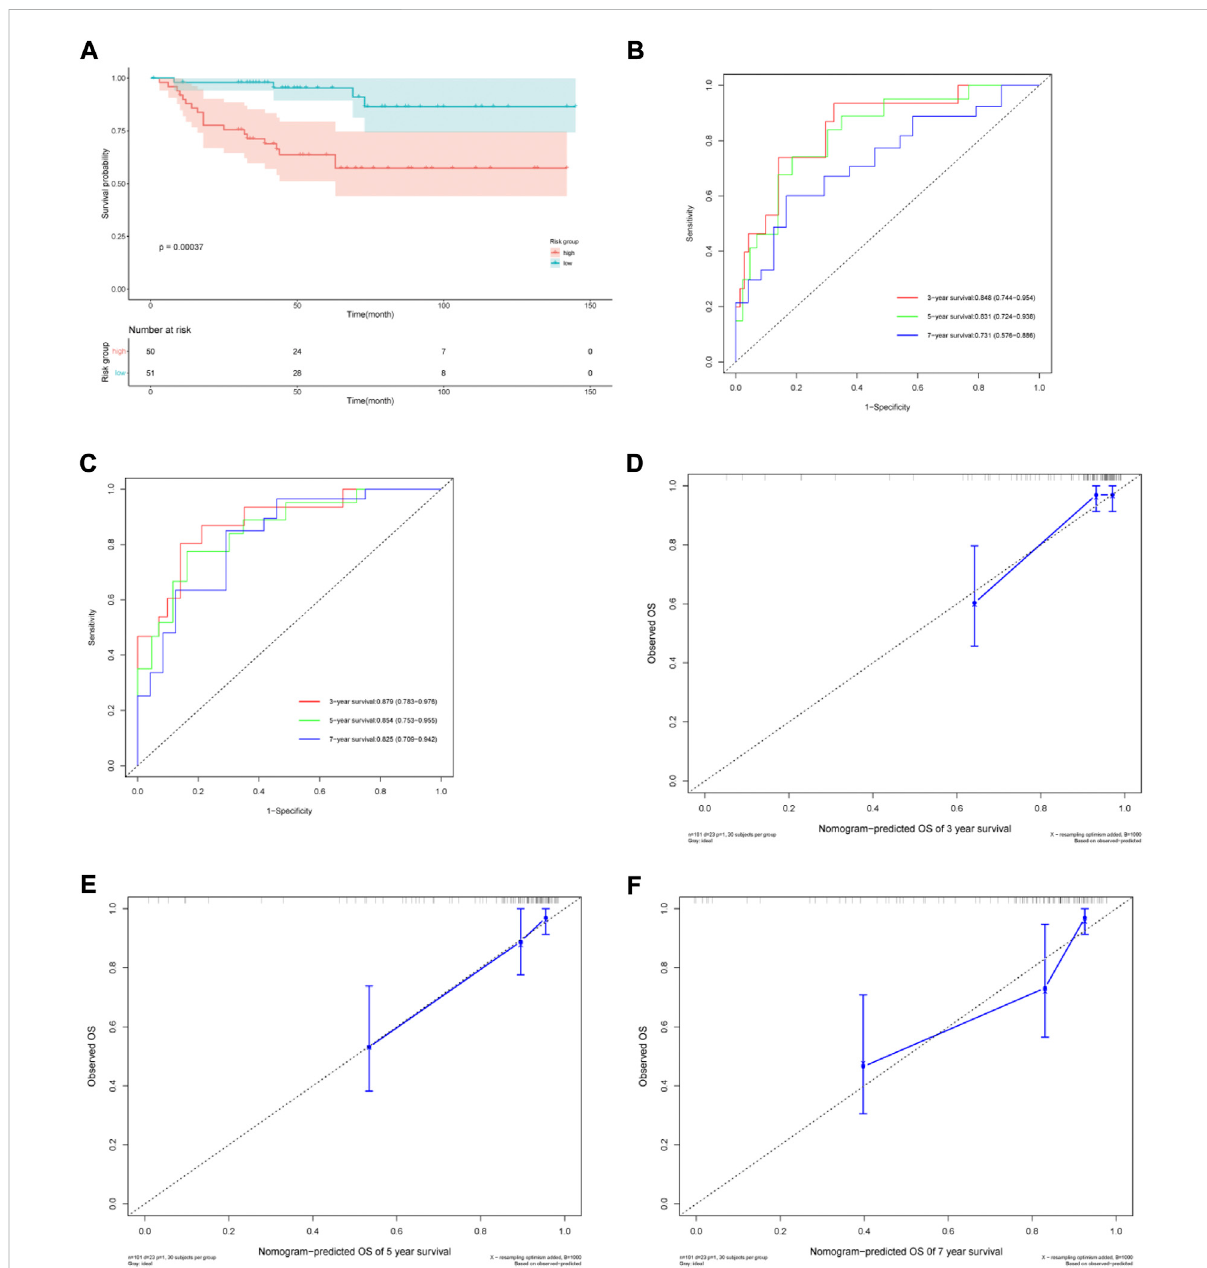
FIGURE 6 Validation of the prognostic risk model and nomogram. (A) Kaplan – Meier (KM) estimate of the overall survival (OS) in the two risk groups in the validation cohort. (B) The time-dependent ROC curves of the risk model for 3-, 5- and 7-year survival prediction in the validation cohort. (C) The time-dependent ROC curves of the nomogram for 3-, 5- and 7-year survival prediction in the validation cohort. (D – F) Calibration curves of the nomogram prediction of 3-, 5- and 7-year OS of ccRCC patients in the validation